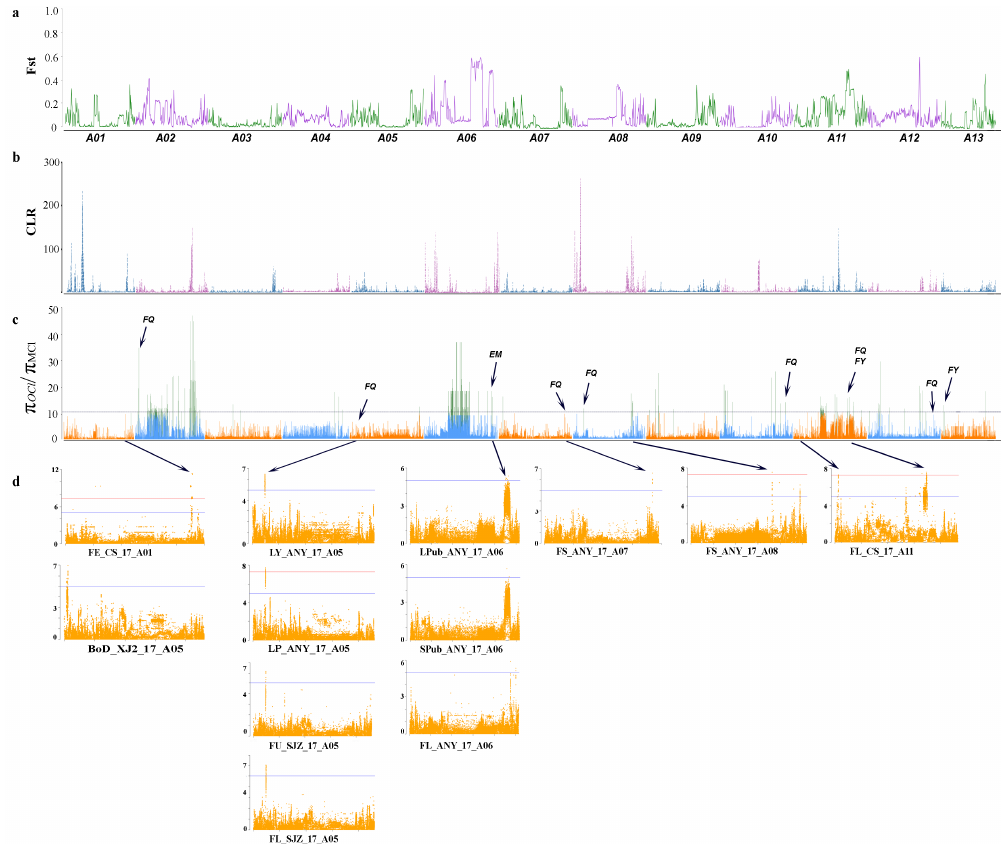
Figure 2. Genetic di ff erentiation and identification of selection sweeps between OCl and MCl on At sub-genome ( a ) Population fixation statistics ( F st) for At sub-genome (Chr A01–A13). A threshold of top 1% is selected as highly di ff erentiated regions, ( b ) CLR (Composite likelihood ratio) score as an estimate of genome-wide selection sweeps, ( c ) π OCl / π MCl values (genetic diversity in the cultivated group as compared to obsolete cultivars from Southwest China) for A genome (Chr A01–A13). π ratio was calculated using whole-genome data with a 100 kb sliding window. The horizontal dotted line represents the threshold of 1% values, whereas the threshold is represented with green columns. The annotations represent as FQ = Fibre quality [28–32], FY = Fibre yield [30] and EM = Early maturity [31,33,34] which donates to previously identified hotspots / quantitative trait loci (QTLs) on the corresponding location, ( d ) Genome-wide association studies’ (GWAS) results as Manhattan plots of multiple traits where purple horizontal line represents suggestive significant threshold with − log10(1 × 10 − 5 ), and the red horizontal line represents genome-wide significant threshold with − log10(5 × 10 − 8 ). FE = Fibre elongation, BoD = Boll opening Days, LY = Lint yield, LP = Lint percentage, FU = Fibre length uniformity, FL = Fibre length, LPub = Leaf pubescence, SPub = Stem pubescence, FS = Fibre strength. ANY = Anyang, Henan Province, CS = Changsha, Hunan Province, SJZ = Shijiazhuang, Hebei